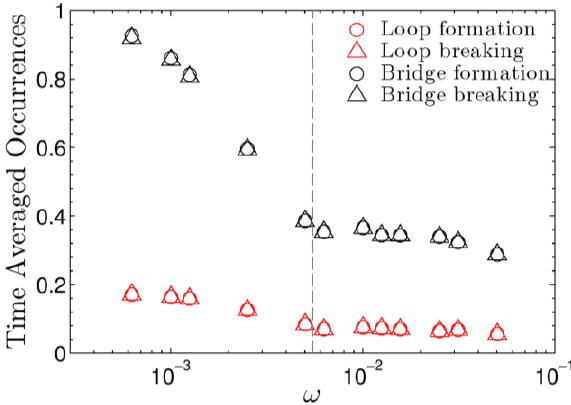
Figure 5. The time averaged number of loop and bridge aggregation events. The crossover frequency is indicated by a dashed line.